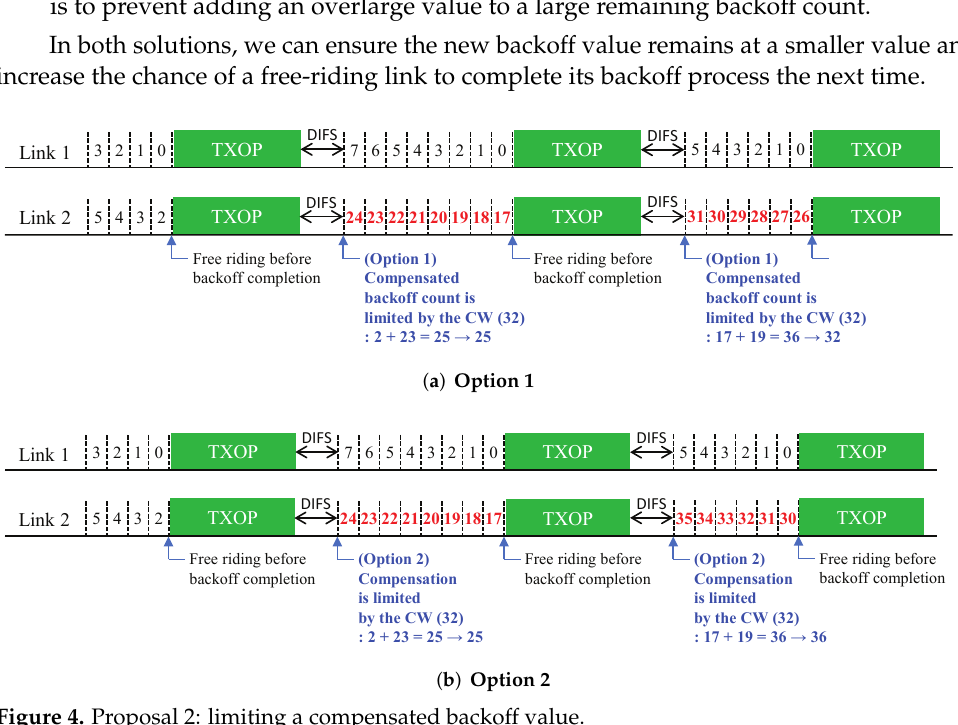
Figure 4. Proposal 2: limiting a compensated backoff